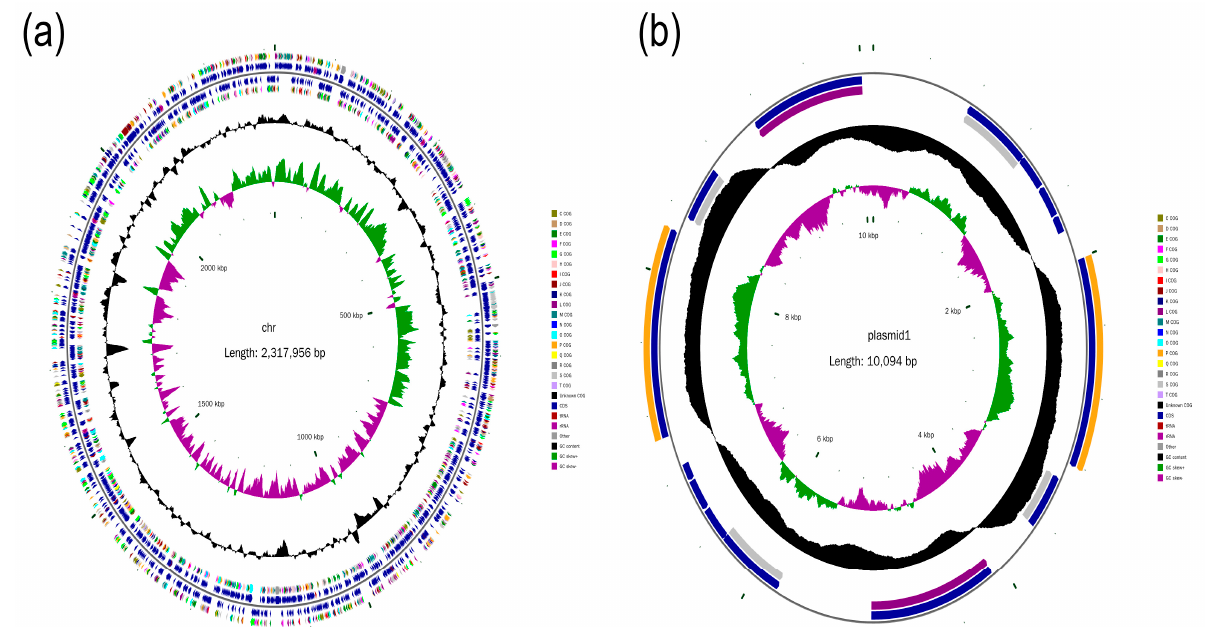
Figure 1. Chromosome genome and plasmid of APP SC1810. ( a ) Chromosome circle map ( b ) Plasmid circle map. From the inside out, the first circle represents the scale; second circle represents the GCSkew; third circle represents the GC content; fourth and seventh circles represent the fifth and sixth circles of COG; to which each coding sequence belongs, representing the position of coding sequence, tRNA and rRNA on the genome.